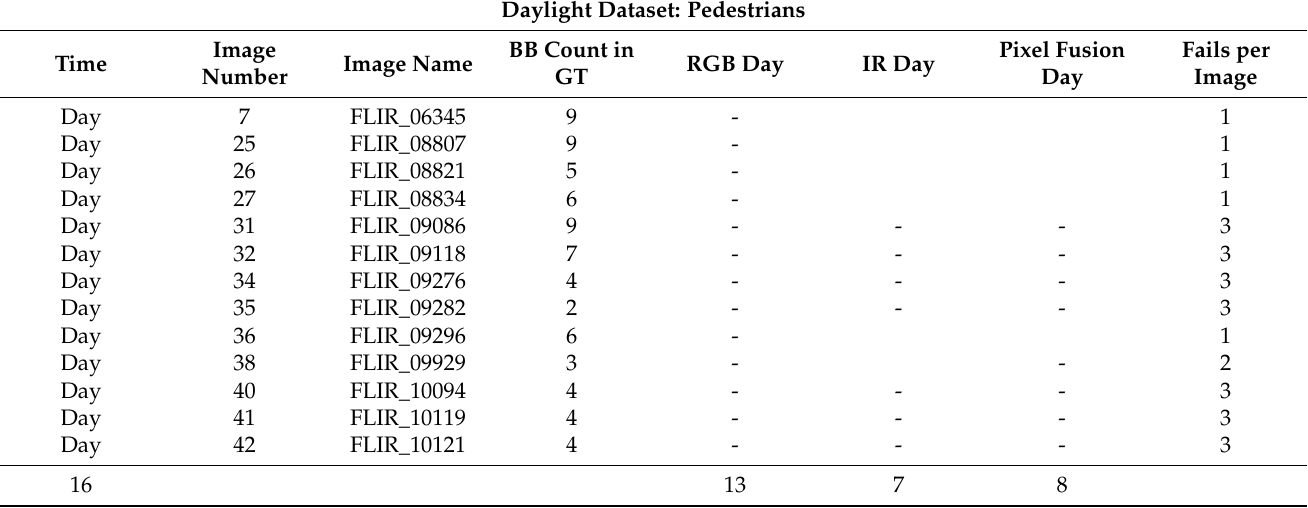
Table A5. Networks trained with day image datasets failed to classify 7–13 images of pedestrian objects out of 16 day images.